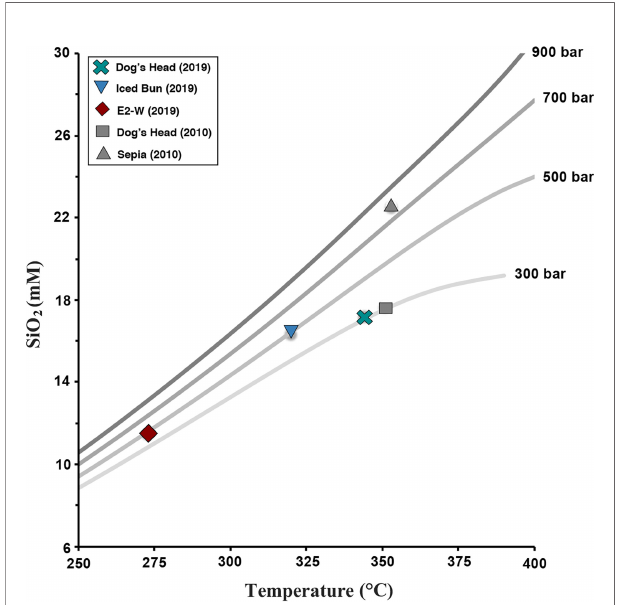
FIGURE 6 | Endmember aqueous SiO 2 concentrations plotted against Tmax of the vent fl uids at E2-S and zero Mg extrapolated temperature for E2-W. The colored symbols represent the samples analysed in this study compared with the samples measured in 2010 (grey). The quartz saturation curves were taken from Foustoukos and Seyfried (2007c) and are represented as a function of pressure from 300 to 900 bar and